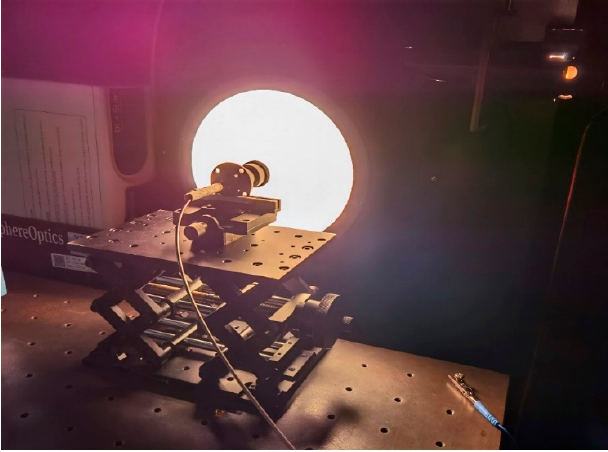
Figure 24. Placement of the telescope and integrating sphere light source during radiation response test.